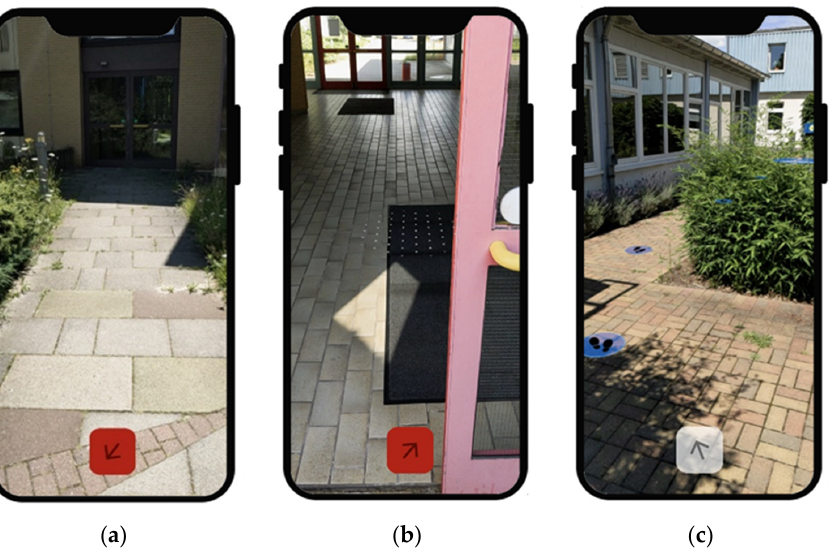
Figure 4. View of smartphone screen showing AR prototype during field study: ( a ) key interaction 1 shows interface during initial orientation; ( b ) key interaction 2 shows interface when entering building, followed by a sharp turn right; and ( c ) key interaction 3 shows interface when vStop was in sight for the first time and information elements look like partly placed off route.